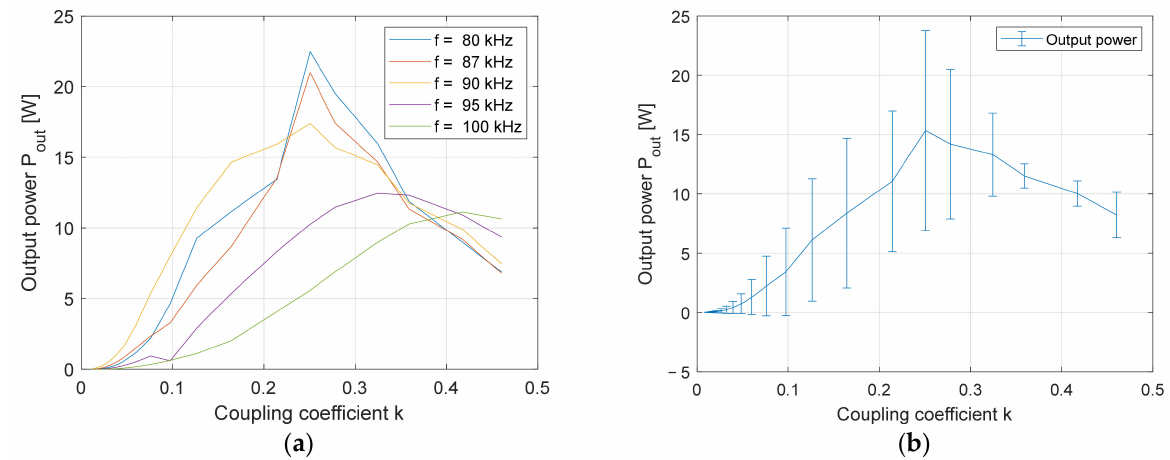
Figure 18. Output power of the IPT using the single DD coil structure: ( a ) at different frequencies; ( b ) average output